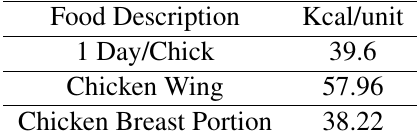
Table 4 Food Calories Conversion Table